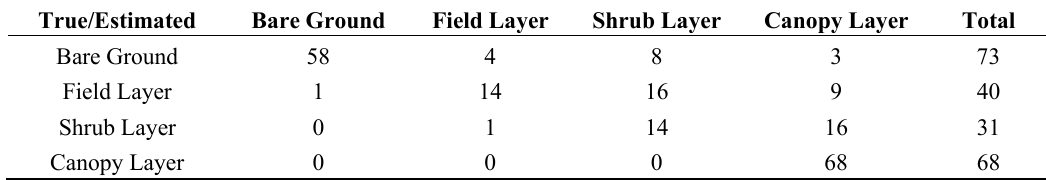
Table 4. Cross-tabulation of vegetation classes using a test set ( n = 212), with true classes in the vertical axis and estimated classes in the horizontal